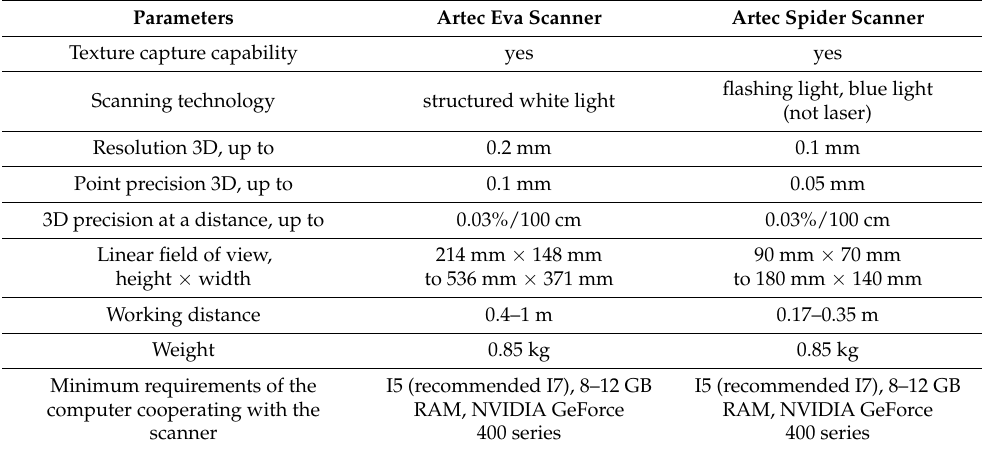
Table 1. Specification of Artec Eva and Spider scanners *.